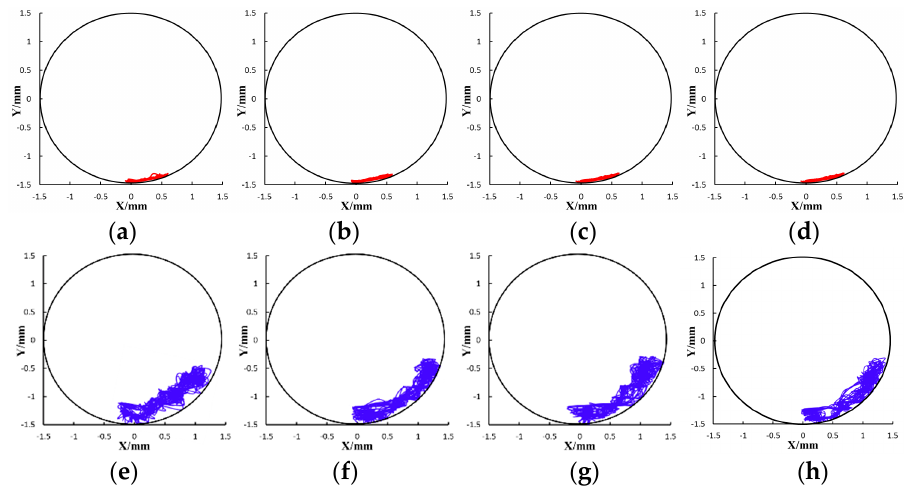
Figure 10. Trajectory curve of BHA center under different WOB: ( a–d ) are the numerical simulation results with 0 N, 0.23 N, 0.46 N, and 0.69 N respectively; ( e–h ) are the experimental results with 0 N, 0.23 N, 0.46 N, and 0.69 N respectively. Table 10. Lateral displacement of BHA under different WOB in numerical simulation.